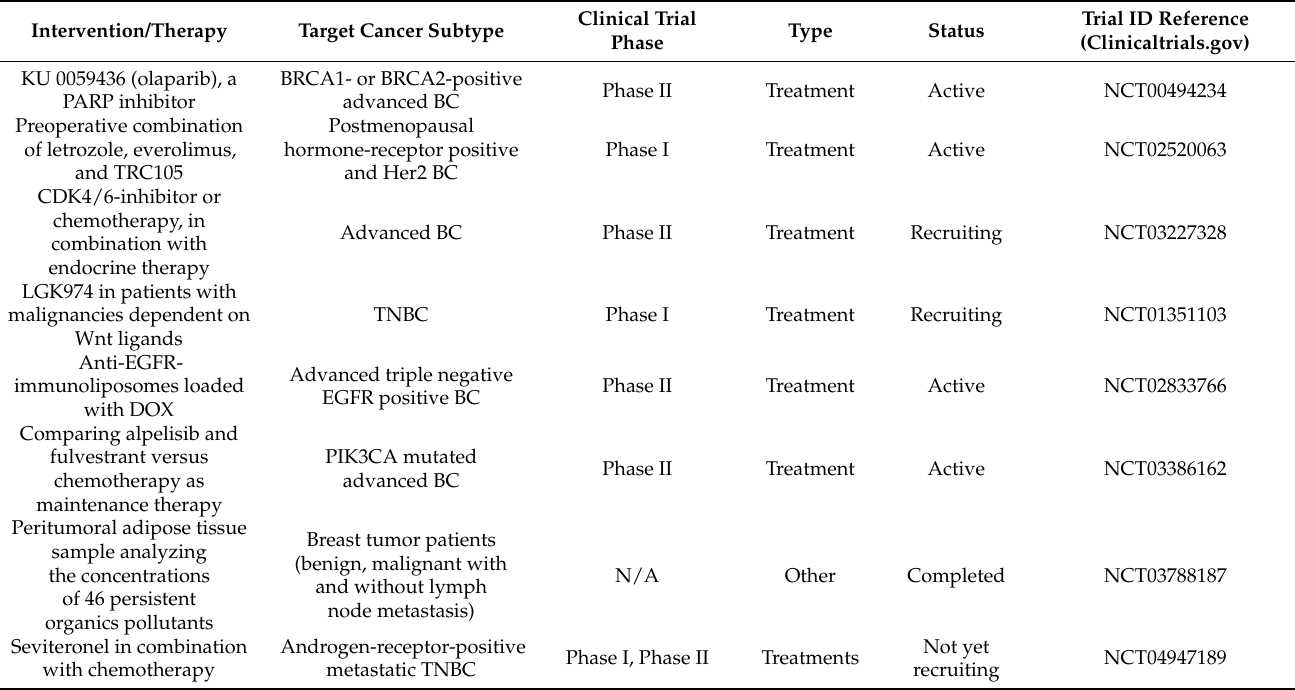
Table 1. Past and current BC clinical trials related to HER2, PARP, EGFR, aryl hydrocarbon receptor (AhR), inducible nitric oxide (iNOS), and